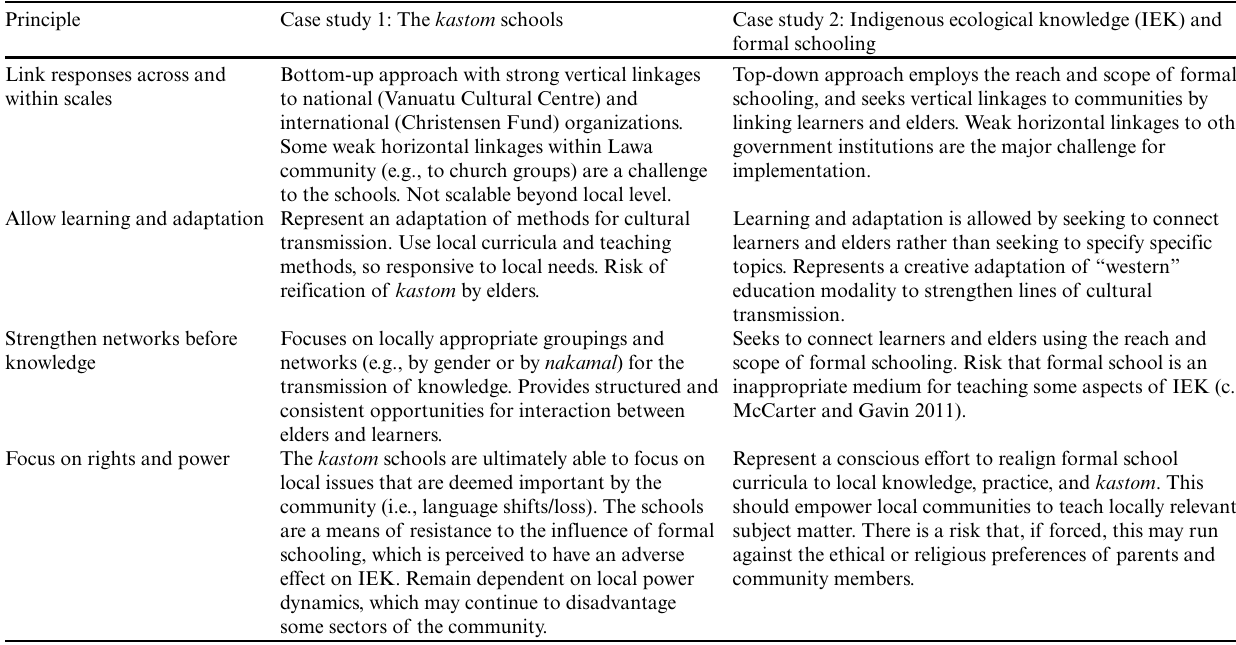
Table 2 . The principles in practice